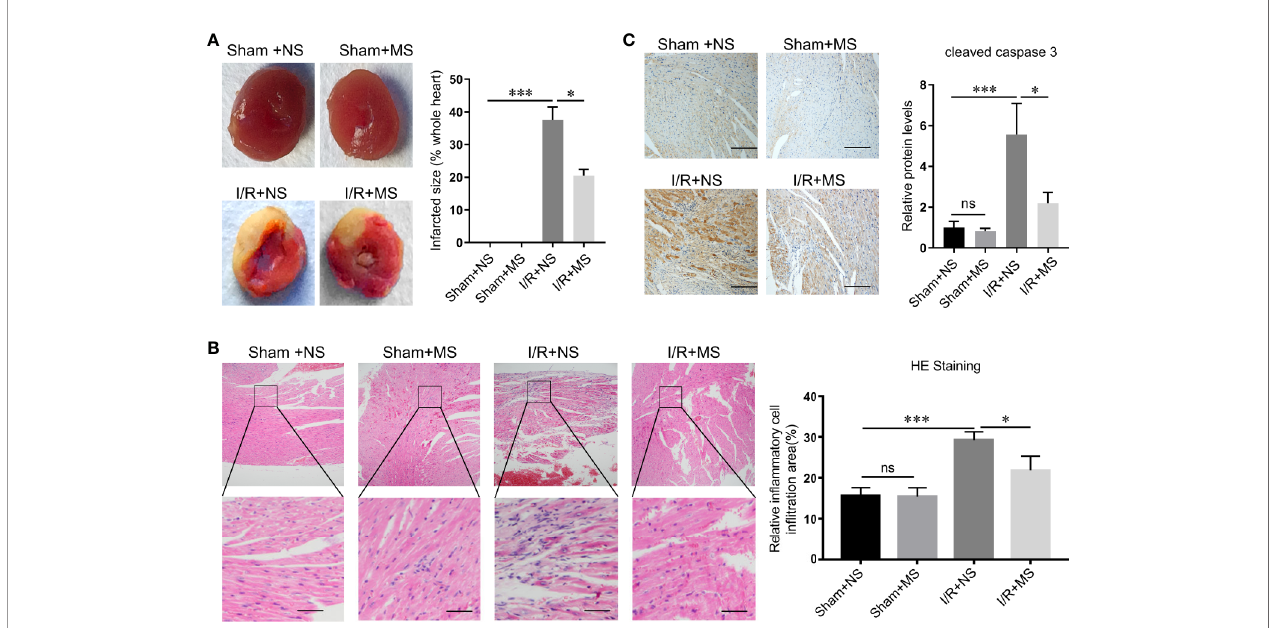
FIGURE 2 | Malva sylvestris L. pretreatment decreases the infarcted size. (A) TTC staining was performed to determine the myocardial infarcted size in I/R rats with or without MS pre-treatment (N = 5). (B) H&E staining was performed to determine the myocardial morphology and in fl ammatory cell in fi ltration in I/R rats with or without MS pre- treatment (left), and the area of in fl ammatory cell in fi ltration was quanti fi ed (right). (C) immunohistochemistry staining was performed to determine the expression of cleaved caspase 3 in myocardial infarcted tissues. *p < 0.05 and ***p < 0.001. ns, no signi fi cance; MS, Malva sylvestris L. ; NS, normal saline; I/R, ischemia-reperfusion.